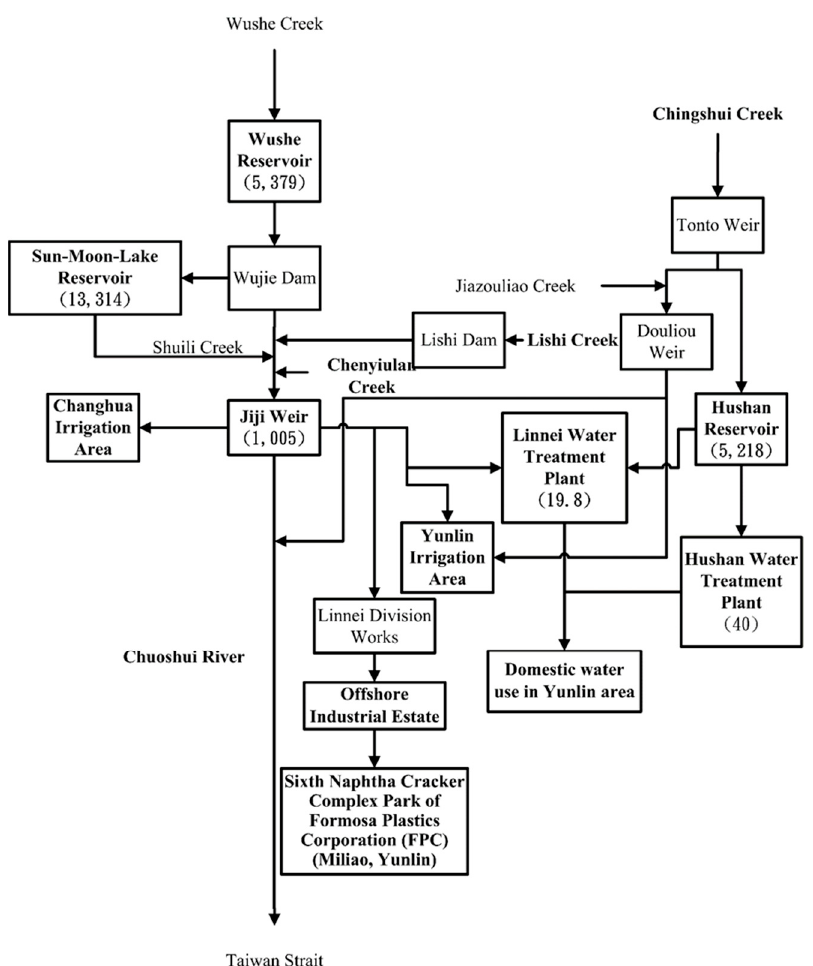
Figure 4. System of water resources allocation in Chuoshui River watershed. Numbers in reservoirs are storage capacity (10 4 cubic meters) and that in Water Purification Stations are the treatment capacity (10 4 cubic meters per day).